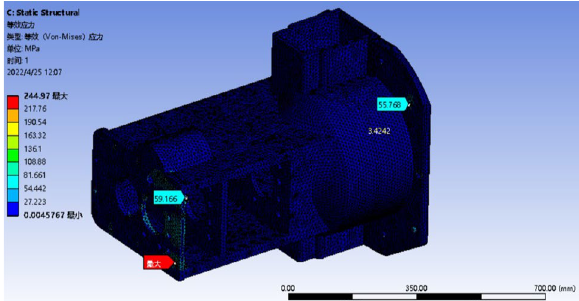
Figure 17. Three stress nephogram.